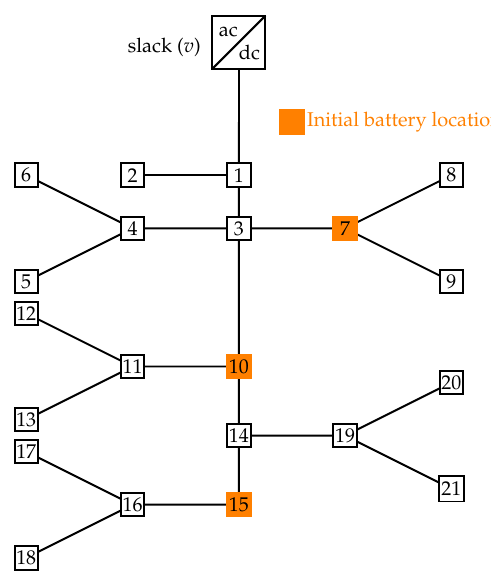
Figure 6. Electrical configuration for the 21-nodes test system. Table 3. Energy purchasing cost and hourly demand.